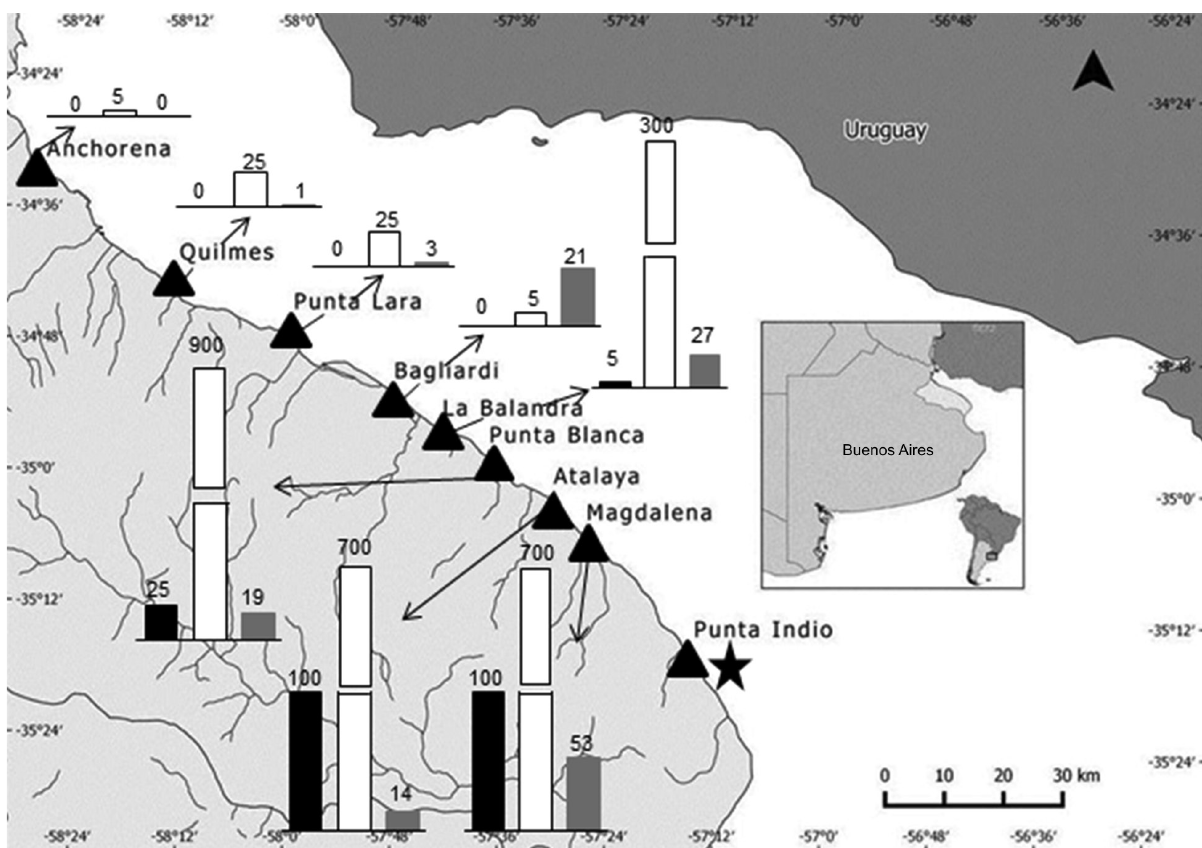
Figure 1. Sampling localities and comparison of densities means, data from Darrigran (1992b) vs. data from present study. Black bars: C. largillierti in 80’s; White bars: C. fluminea in 80’s; Grey bars: C. fluminea 2015/2016. (  ) Sporadic presence of C. fluminea in